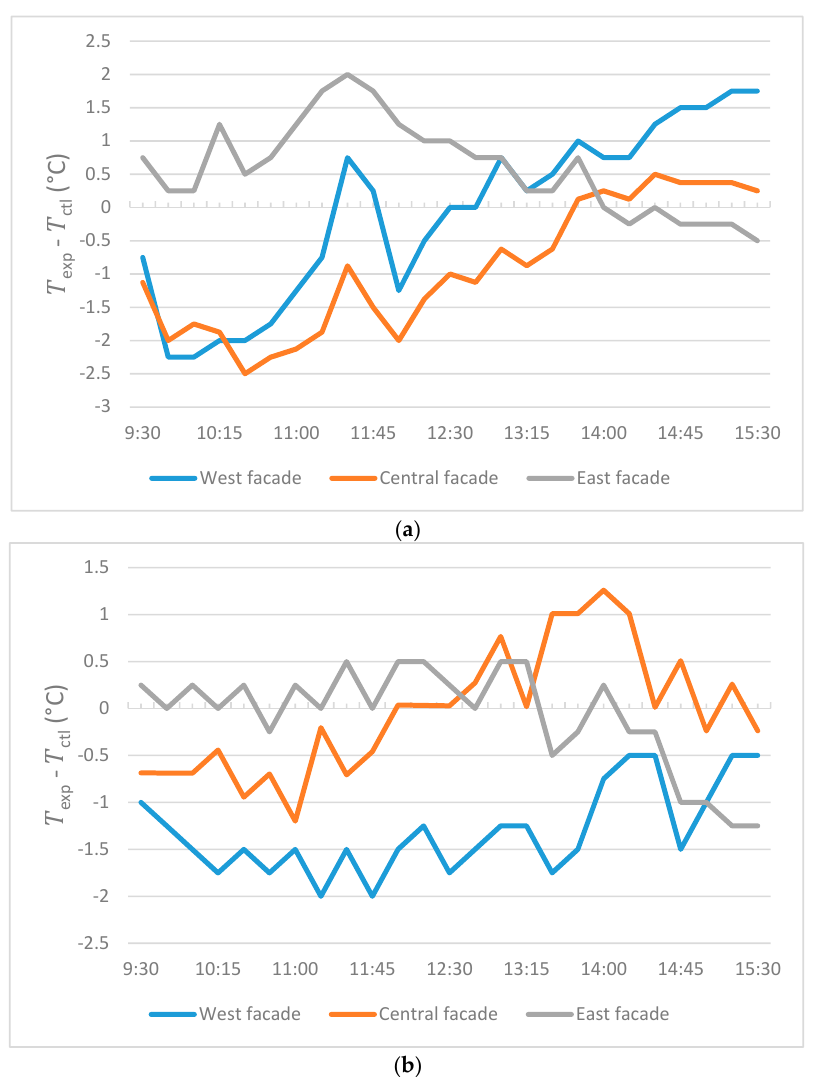
Figure 8. Cooling effect of tree shade on the target building facade temperature (Two-trees). ( a ) Cluster tree arrangement; and, ( b ) Disperse tree arrangement.